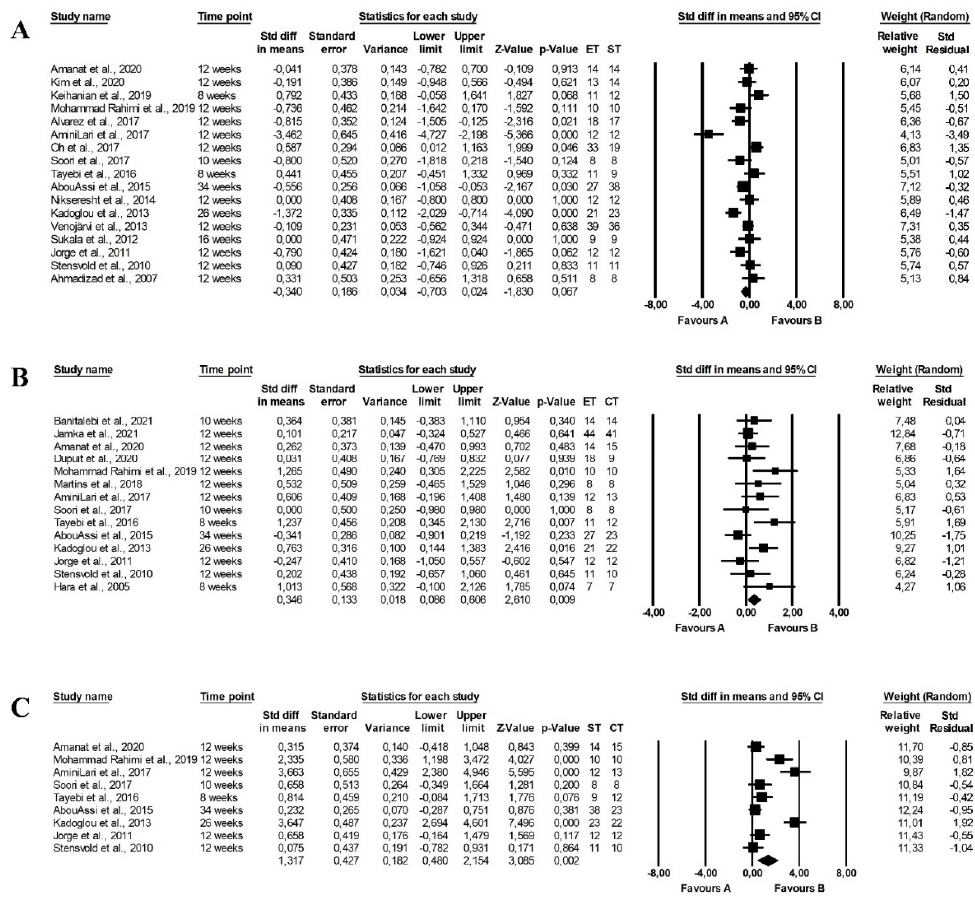
Figure 5. Forest plots of the effect of training programmes on homeostatic model assess- ment of insulin resistance index: ( A ) endurance (favours A) vs. strength (favours B) train- ing (random model) [16,20,22,41,43,45,46,50,51,53,55,58,63,65,68,69,71]; ( B ) endurance